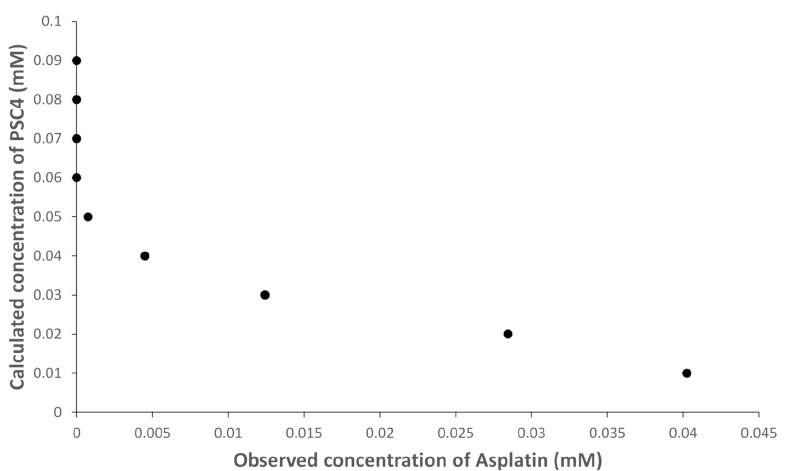
Figure 4. UHPLC observed concentrations of asplatin of solutions containing a fixed concentration of asplatin (0.05 mM) and varying concentrations of PSC4 (0.01–0.09).